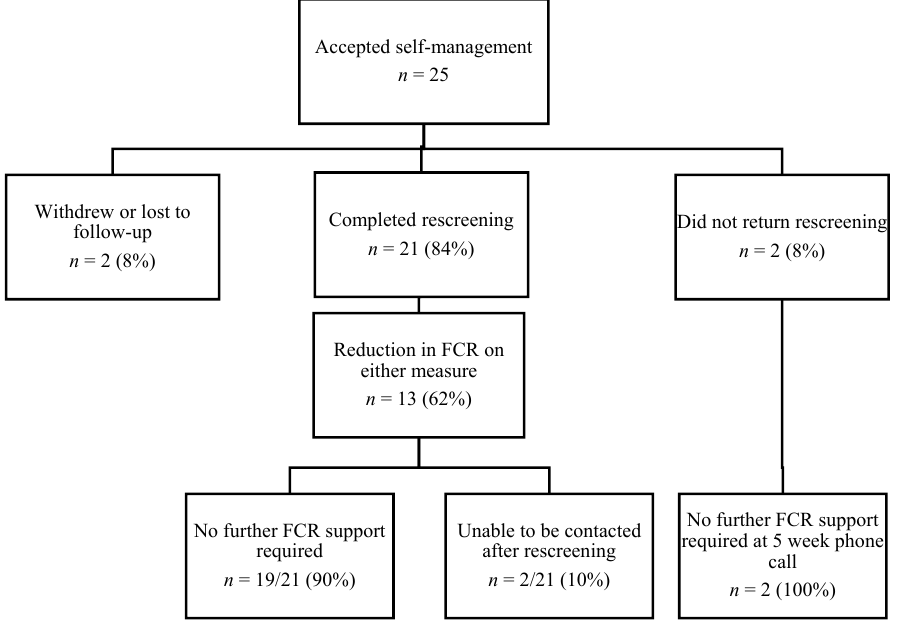
Figure 3. Self-management intervention flow of participants.